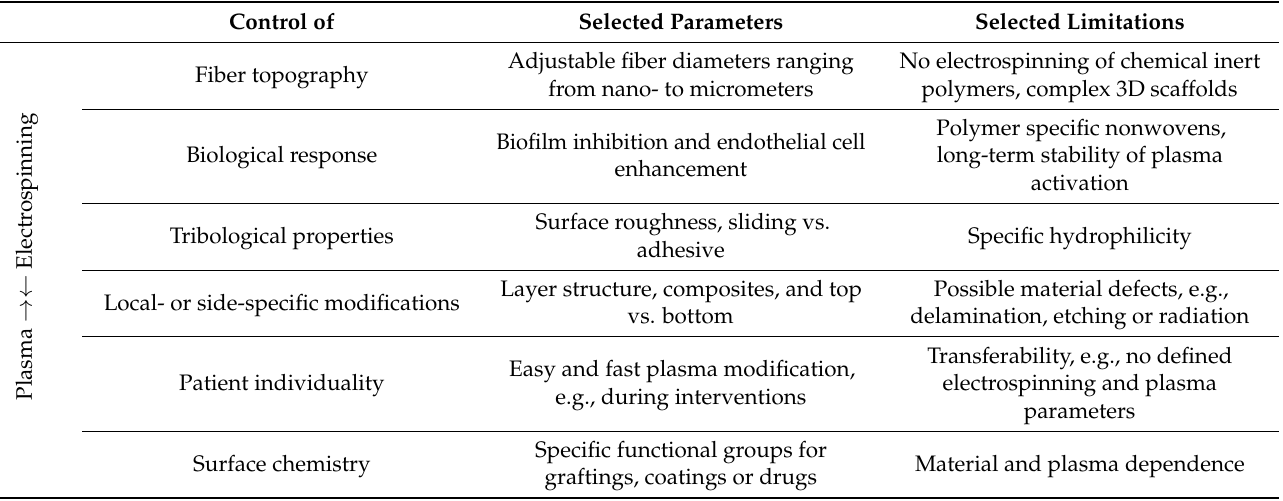
Table 2. Exemplary potentials and limitations of plasma surface treatment of electrospun poly- mer